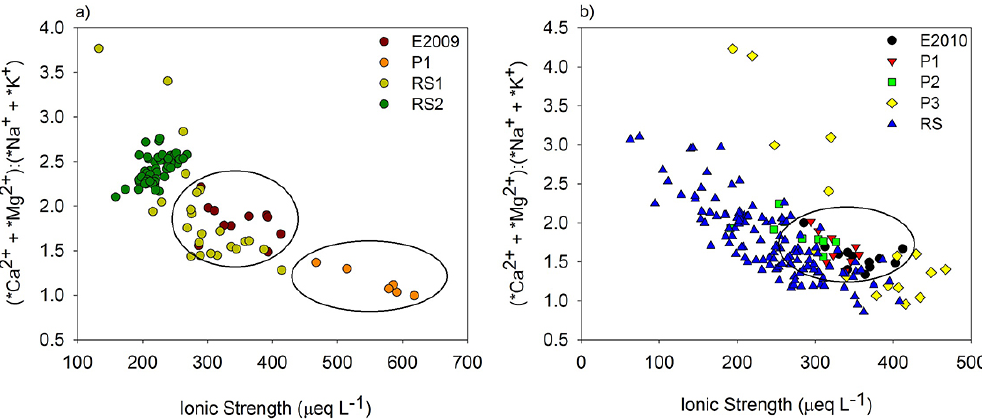
Figure 4. Associations between ionic strength and (*Ca 2 + + *Mg 2 + ) :(*Na + + *K + ) in subglacial runoff from 2009 (a) and 2010 (b) . P-event (P) waters have been highlighted. RS refers to water exported throughout the remainder of the melt season, subdivided into RS1 and RS2 in 2009 due to contrasting geochemistry. Table 1. POC, DOC and free carbohydrate (FCHO) abundance in bulk runoff, subglacial and supraglacial samples collected in